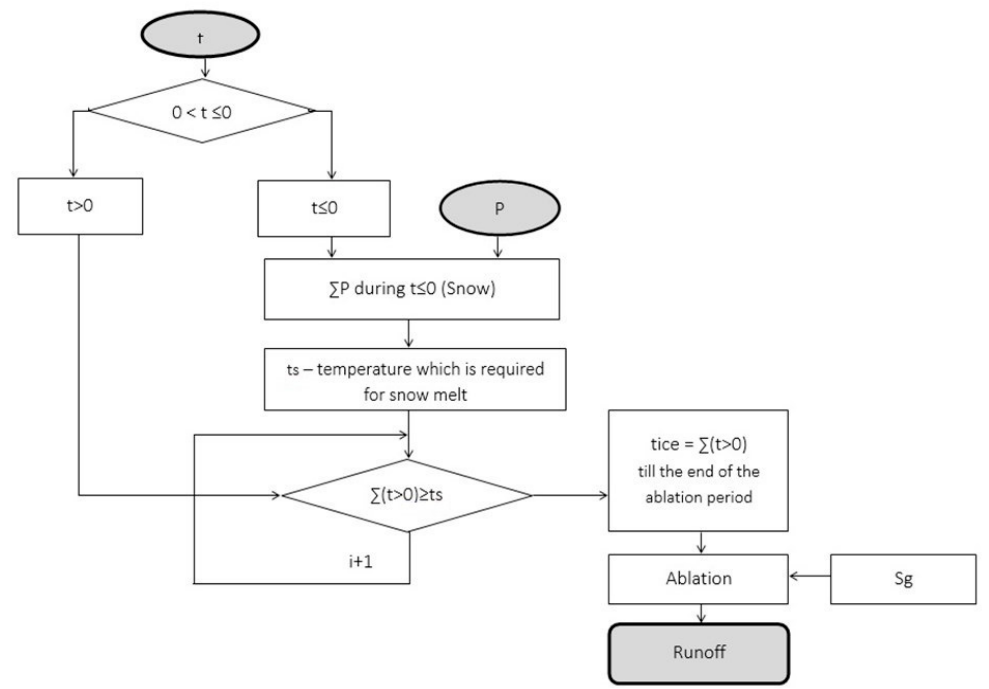
Figure 3. The scheme of the positive degree-day (PDD) glacier runoff model. t—daily temperature, P—daily precipitation, ts—sum of the temperature which is needed for complete snow melt, Sg—glacier area.